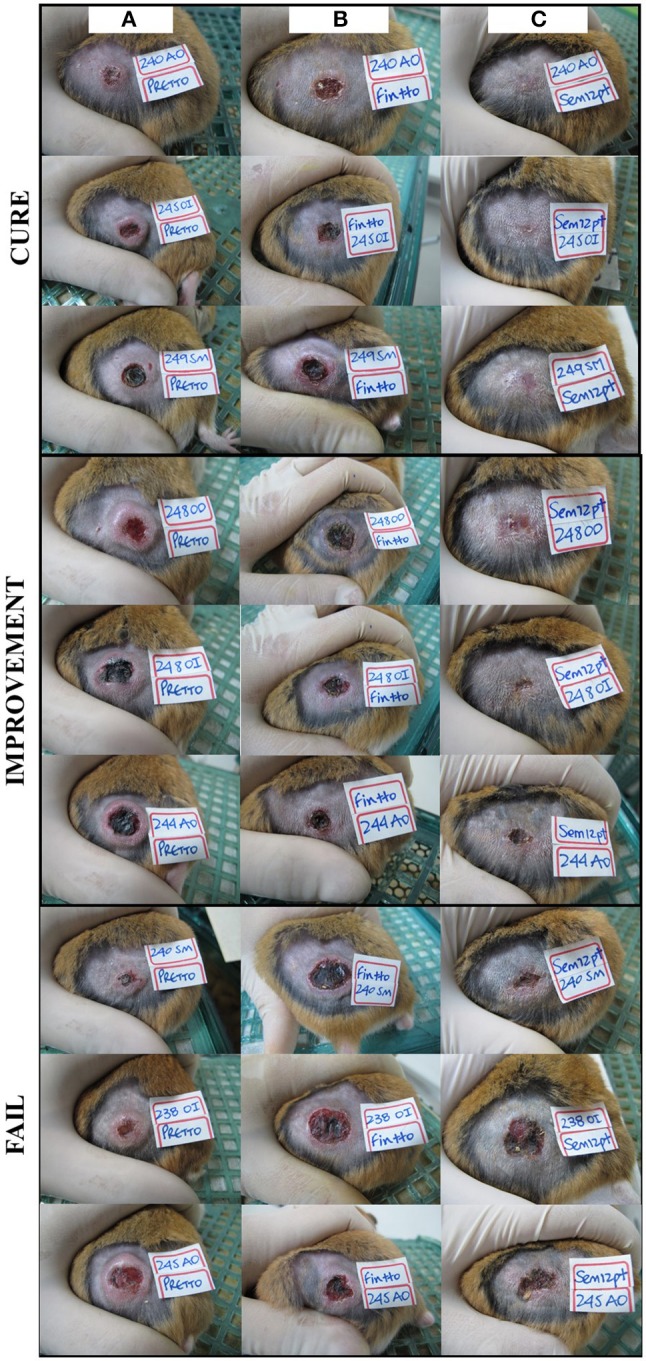
Treatment progress of cutaneous leishmaniasis in hamsters experimentally infected with L. (V) braziliensis. A representative photograph of lesion, (A) before treatment, (B) end of treatment, and (C) 90 days post-treatment. Note the complete re-epithelialization of the skin in cured hamsters, the decrease in size of the injury during improvement or the increases in the size of the injury during fail to treatment.